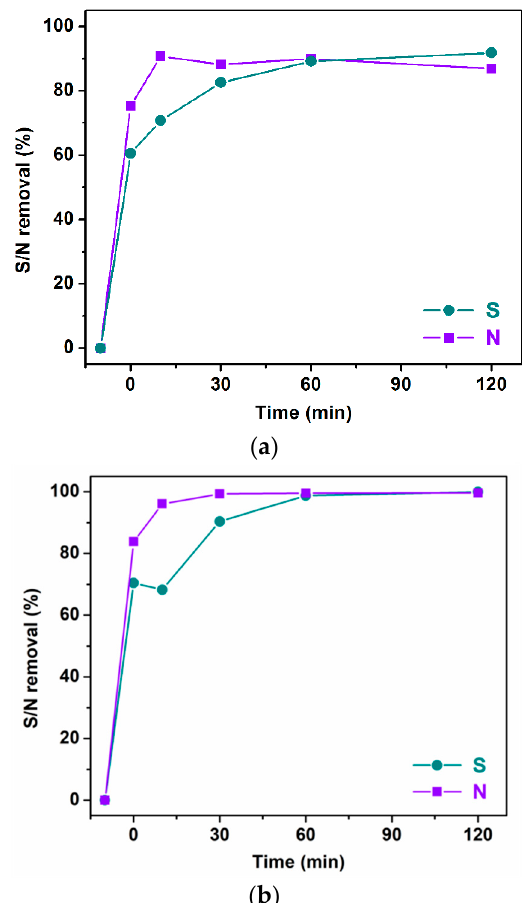
Figure 3. Desulfurization and denitrogenation of a multicomponent model fuel (BT, DBT, MDBT, DMDBT, IND, QUI) catalysed by the heterogeneous [BMIM] 3 PMo 12 @ZIF-8 ( a ) and the homogeneous [BMIM] 3 PMo 12 ( b ), using [BMIM]PF 6 as extraction solvent and H 2 O 2 as